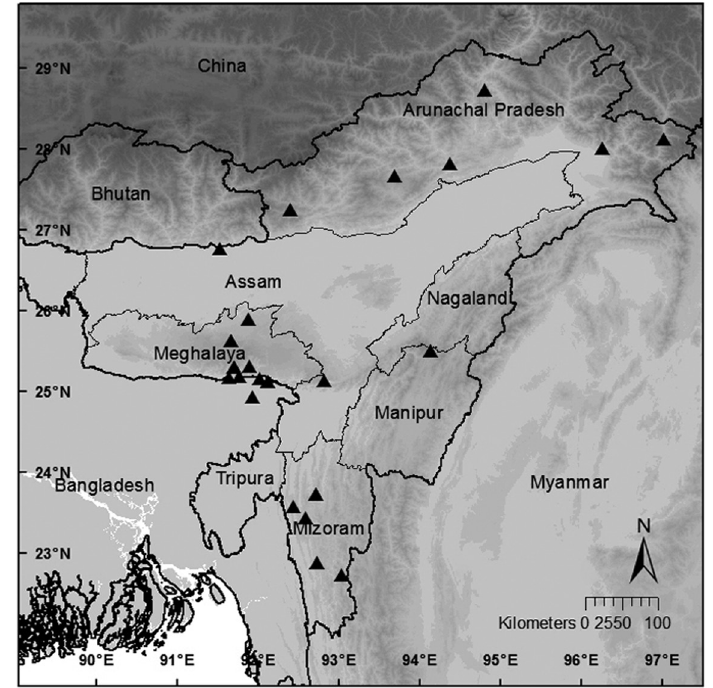
Fig. 28. Map showing the location of B. hatacoa Buch.-Ham. ex D.Don